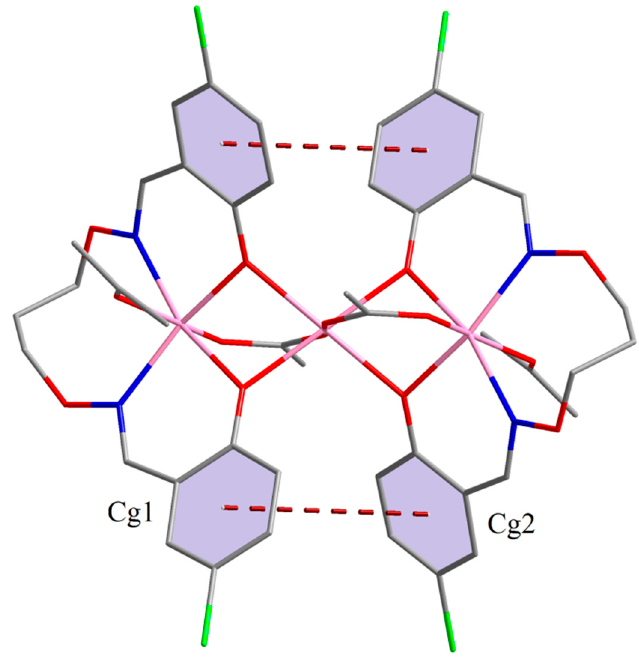
Figure 6. π ⋯ π interactions of coordination compound 1 . Figure 6. π · · · π interactions of coordination compound 1